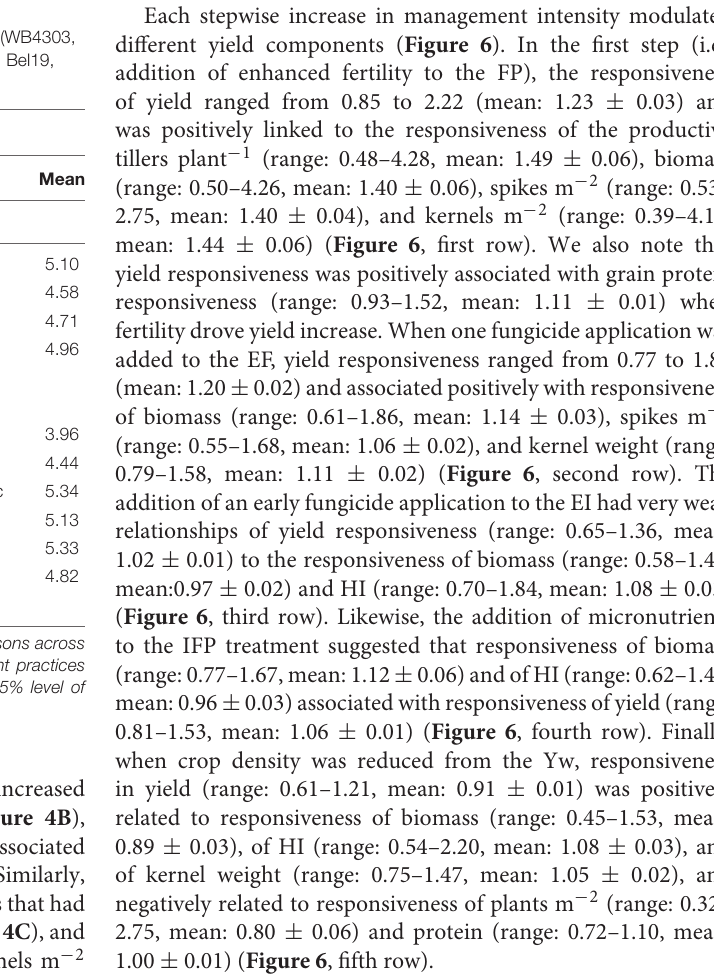
TABLE 3 | Least square mean winter wheat grain yield as affected by management practices (FP, EF, EI, IFP, Yw, and IPP), wheat genotypes (WB4303, WB4458, WB-Grainfield, and Zenda), and environments (Bel18, Hut18, Bel19, and Hut19).